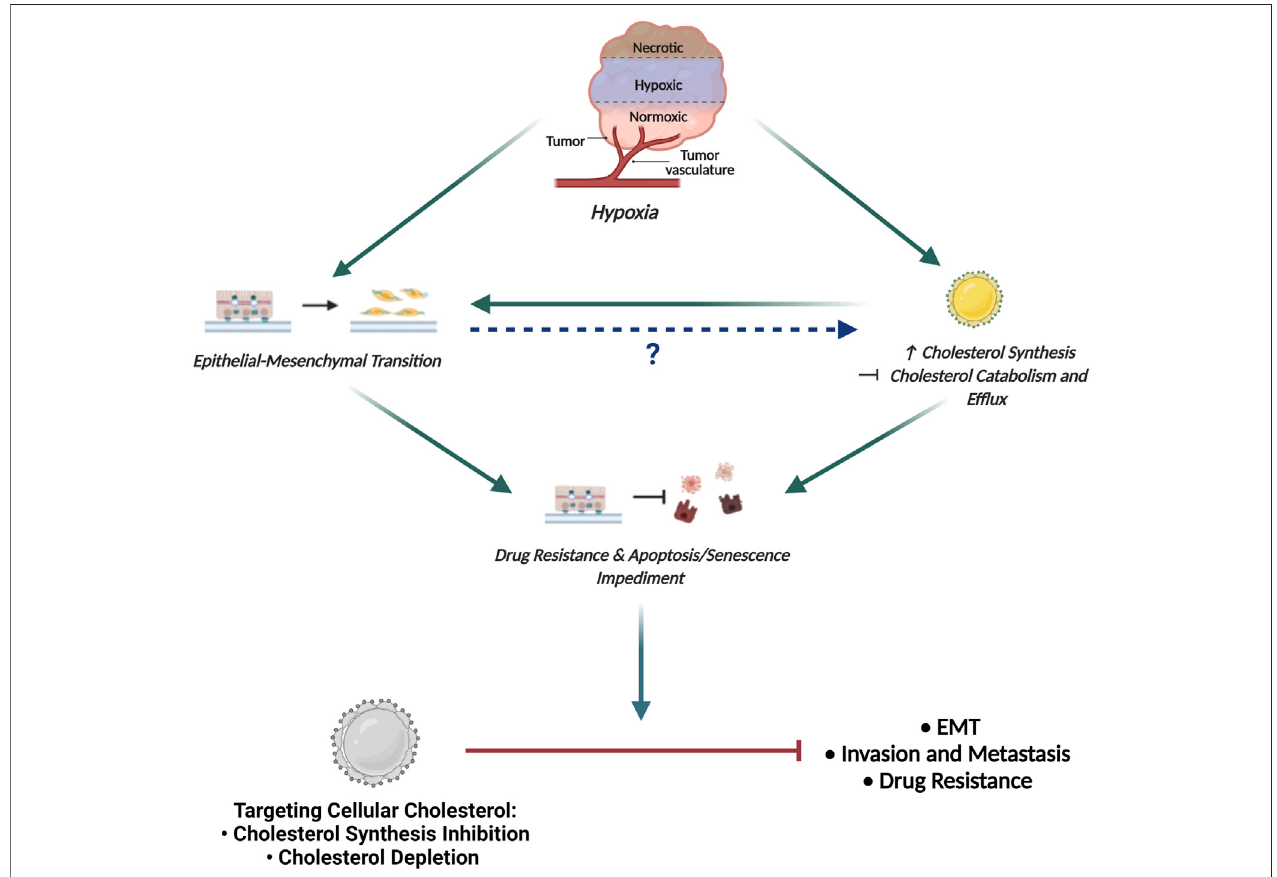
FIGURE 5 | Proposed Model Delineating the link between Hypoxia, EMT and Cholesterol in Cancer. The hypoxic tumour microenvironment facilitates EMT induction and promotes increased cellular cholesterol availability by enhancing mechanisms associated with cholesterol synthesis and impeding cholesterol catabolism and ef fl ux. While increased cholesterol content is seen to fuel EMT, how EMT affects the cellular cholesterol pro fi le has not been delineated. Importantly, both EMT and increased cholesterol content isseentoenhance drug resistance and impedeapoptotic and senescence induction. Weproposethat targeting cellularcholesterol, either through cholesterol synthesis inhibition or depletion, will combat EMT, decrease the invasive and metastatic potential of cells and also restore sensitivity to conventional chemotherapeutic agents.